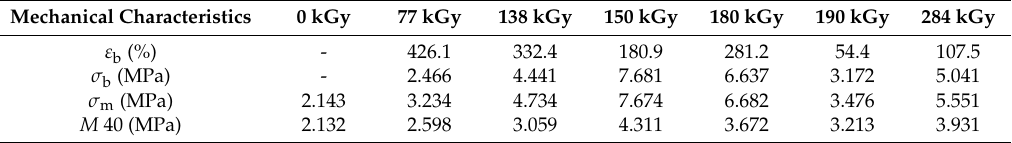
Table 1. Experimental values of mechanical characteristics ε b , σ b , σ m and M 40 for the virgin sample of PMX3 polymer system and samples irradiated with individual radiation